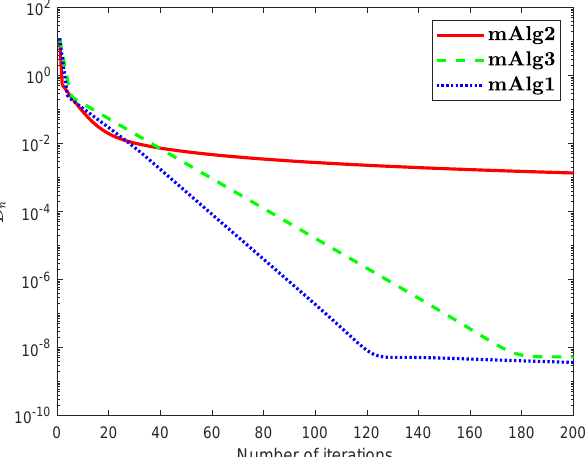
Figure 9. Algorithm 1 compared to Algorithm (60) and Algorithm 3.2 in [34] for u 0 = 1 + 2 t + sin ( t ) .